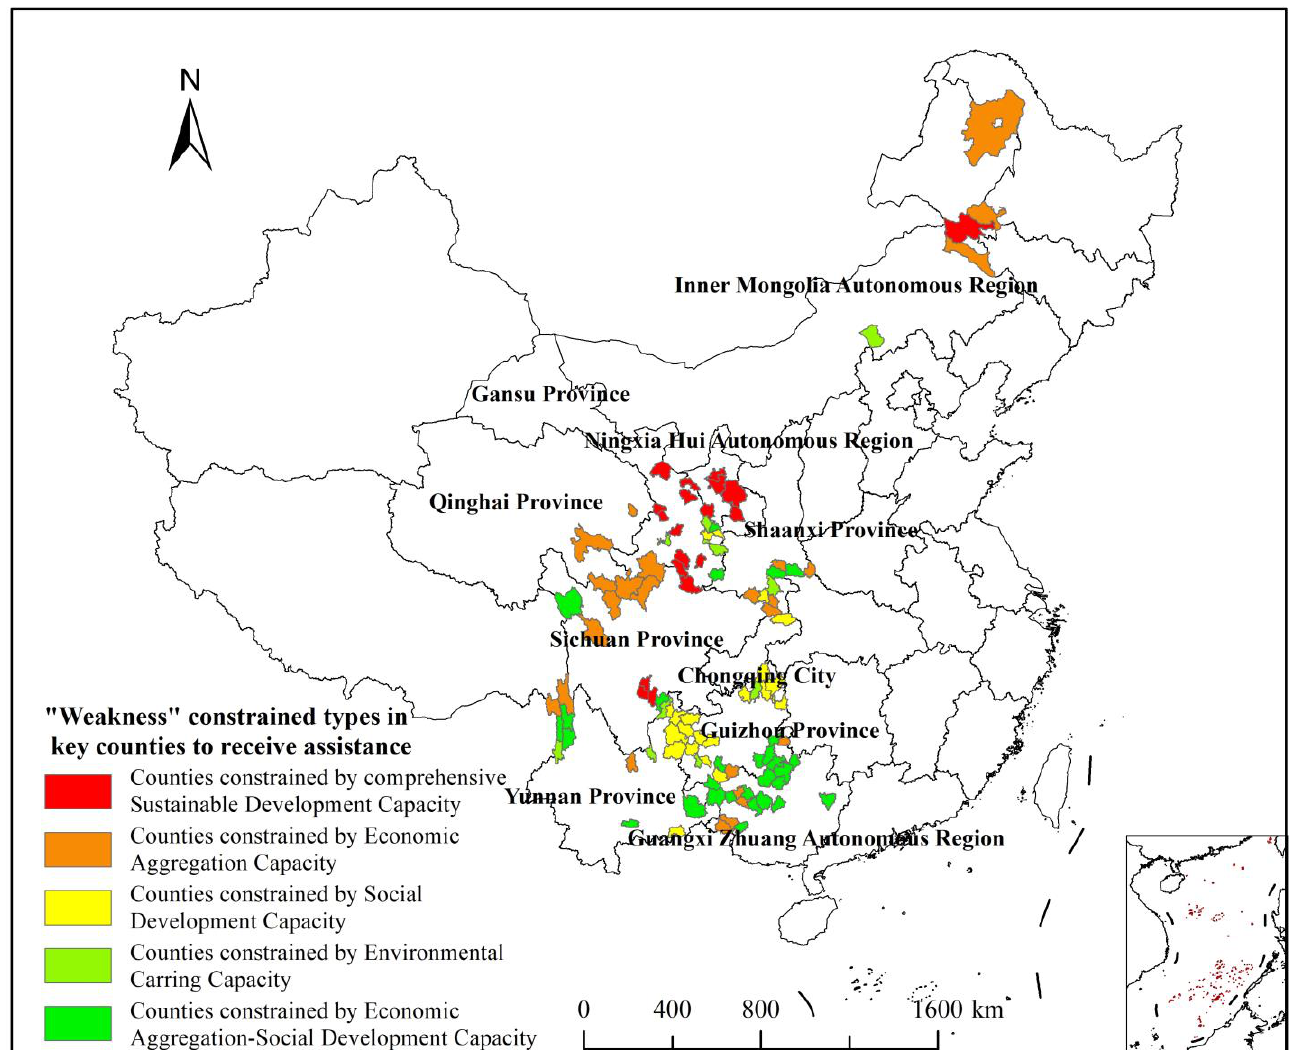
Figure 4. Distribution of the “weakness”-constrained types in 103 key counties to receive assistance.